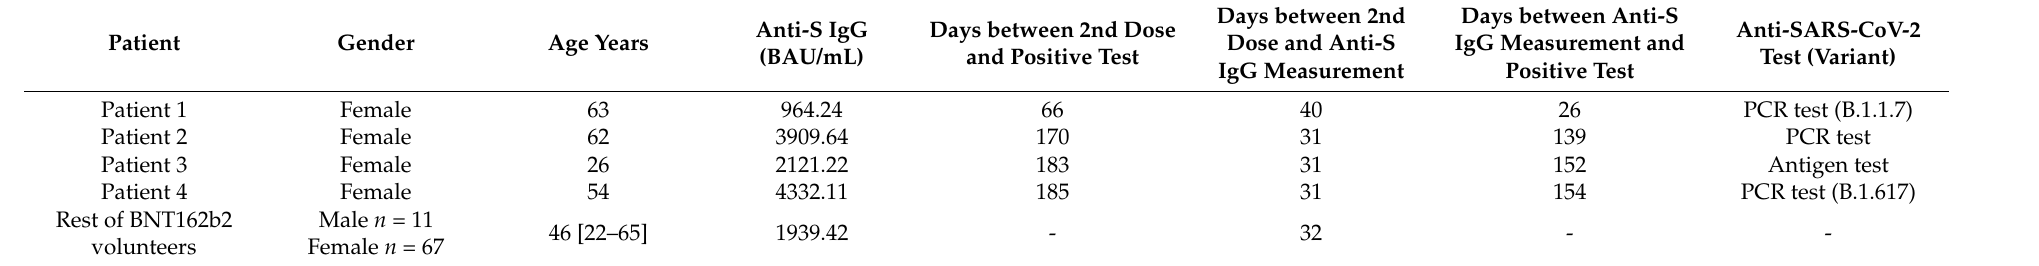
Table 3. Characteristics of the patients infected between day 30 and day 240